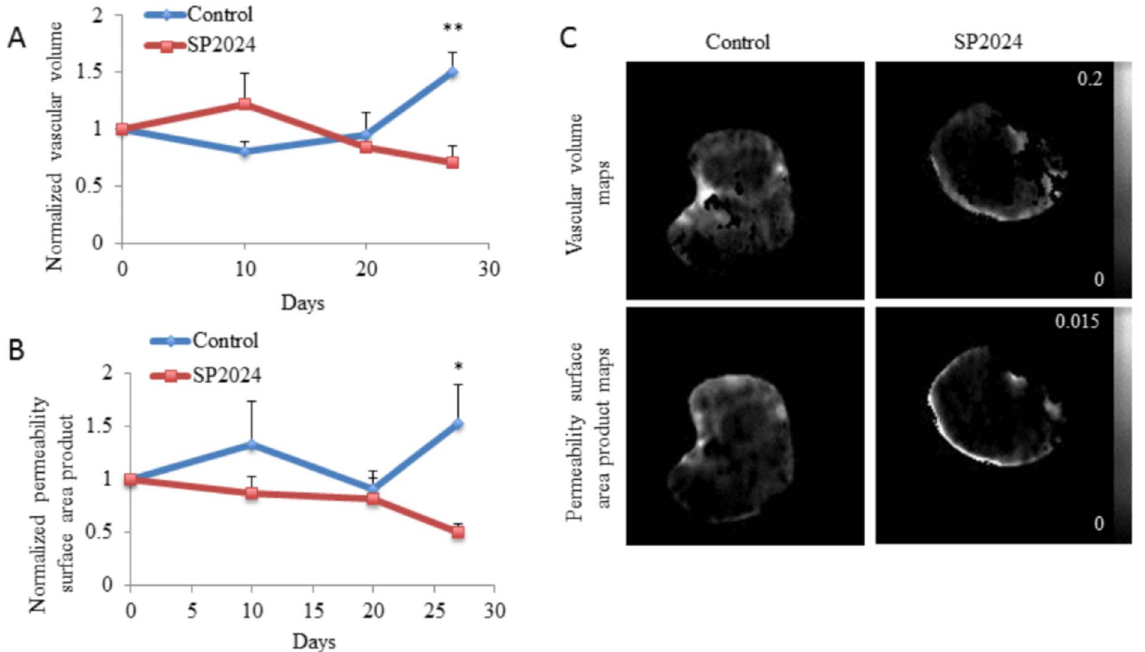
Figure 6. Vascular Volume and Permeability Surface Area Product. Vascular volume and vascular PSP measurement using albumin-GdDTPA contrast MRI. (A) Changes in vascular volume as a result of the daily i.p. injections with SP2024, with significant difference (p , 0.01) on day 27. (B) Changes in the vascular PSP with significant difference (p , 0.05) on day 27. (C) Representative vascular volume and PSP maps for the SP2024 treated groups in comparison to the control group.